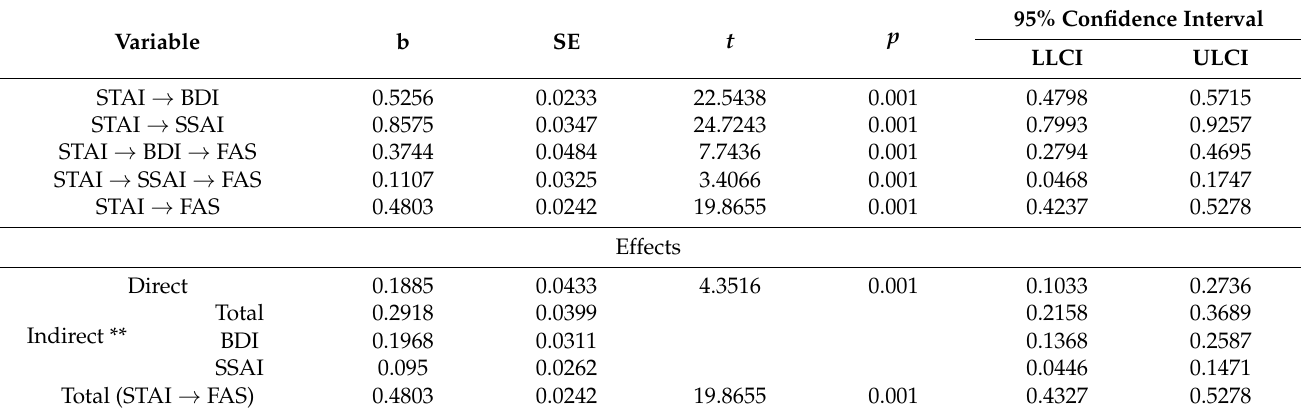
Table 4. Mediation analysis of Beck Depression Inventory (BDI) and Spielberger State Anxiety